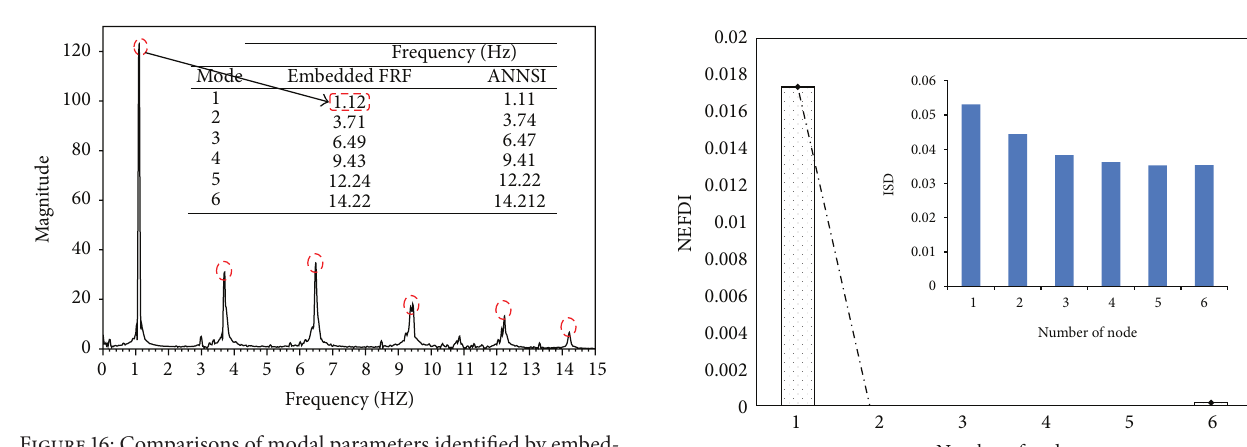
Figure 16: Comparisons of modal parameters identified by embed- ded FRF and ANNSI. Table1:TheprocessingtimeofembeddedFFTandFRFfordifferent data lengths.